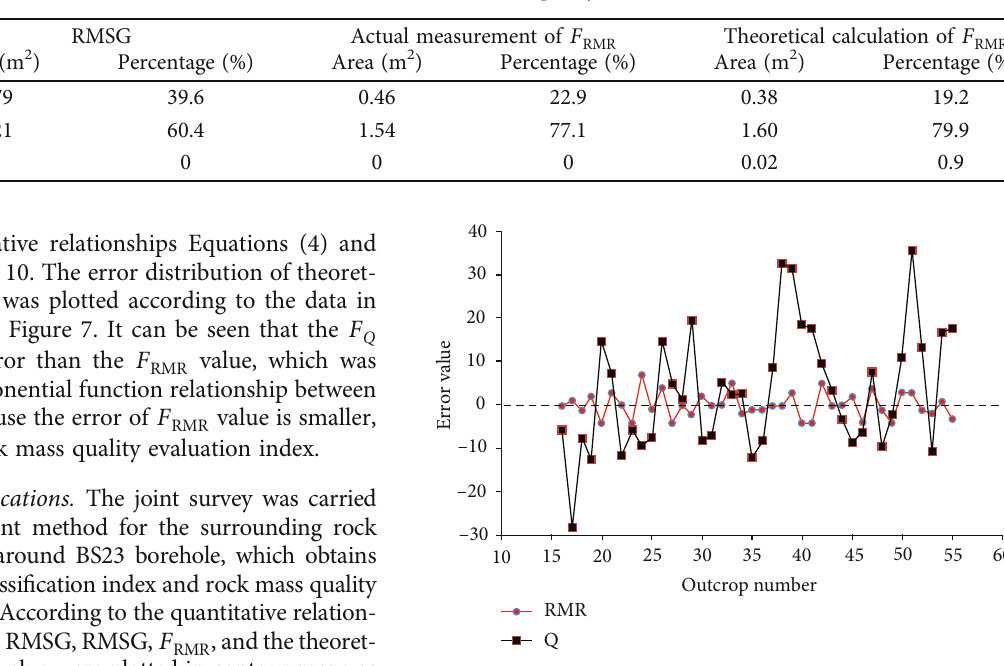
Table 10: Comparison of theoretical and actual values of F